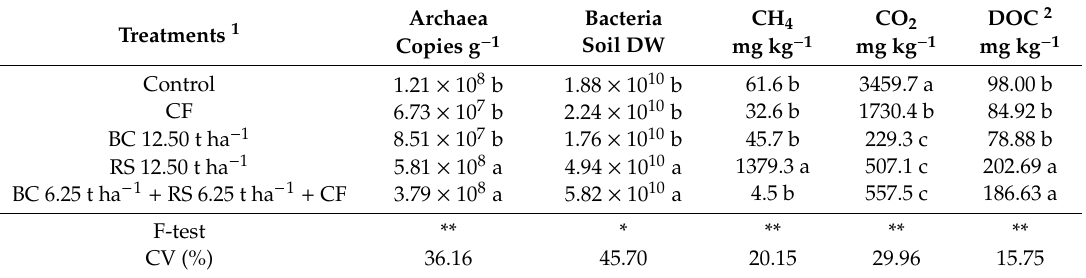
Table 4. The abundance of archaea and bacteria, CH 4 and CO 2 production, and DOC content in 14-day incubated soils treated with BC and